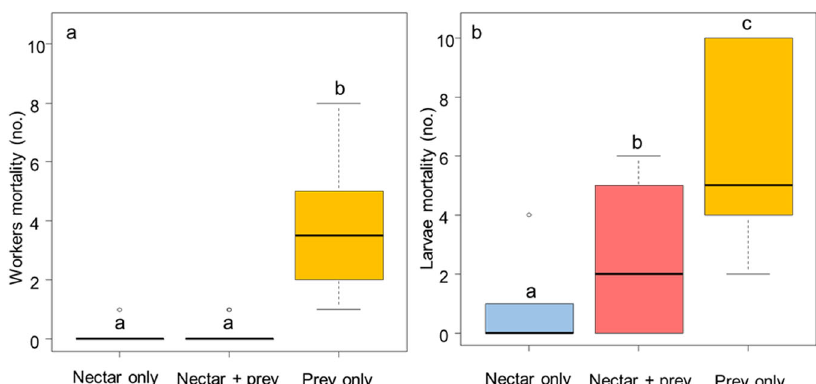
Fig. 4 Mortality of hornets fed with different diets. Mortality of workers a and larvae b fed with nectar only (in light blue), nectar and prey (in light red), and prey only (in yellow) (workers; nectar only group: N = 31, nectar + prey group: N = 32, and prey only group: N = 68; larvae: N = 100 per group). The boxes represent the fi rst and third quartiles and the median. The whiskers represent the maximum and minimum values. The circles represent the outliers. A generalized linear mixed model followed by post-hoc pairwise comparisons (Tukey adjusted) was used for statistical analysis. Different letters indicate a pairwise-comparison with P <